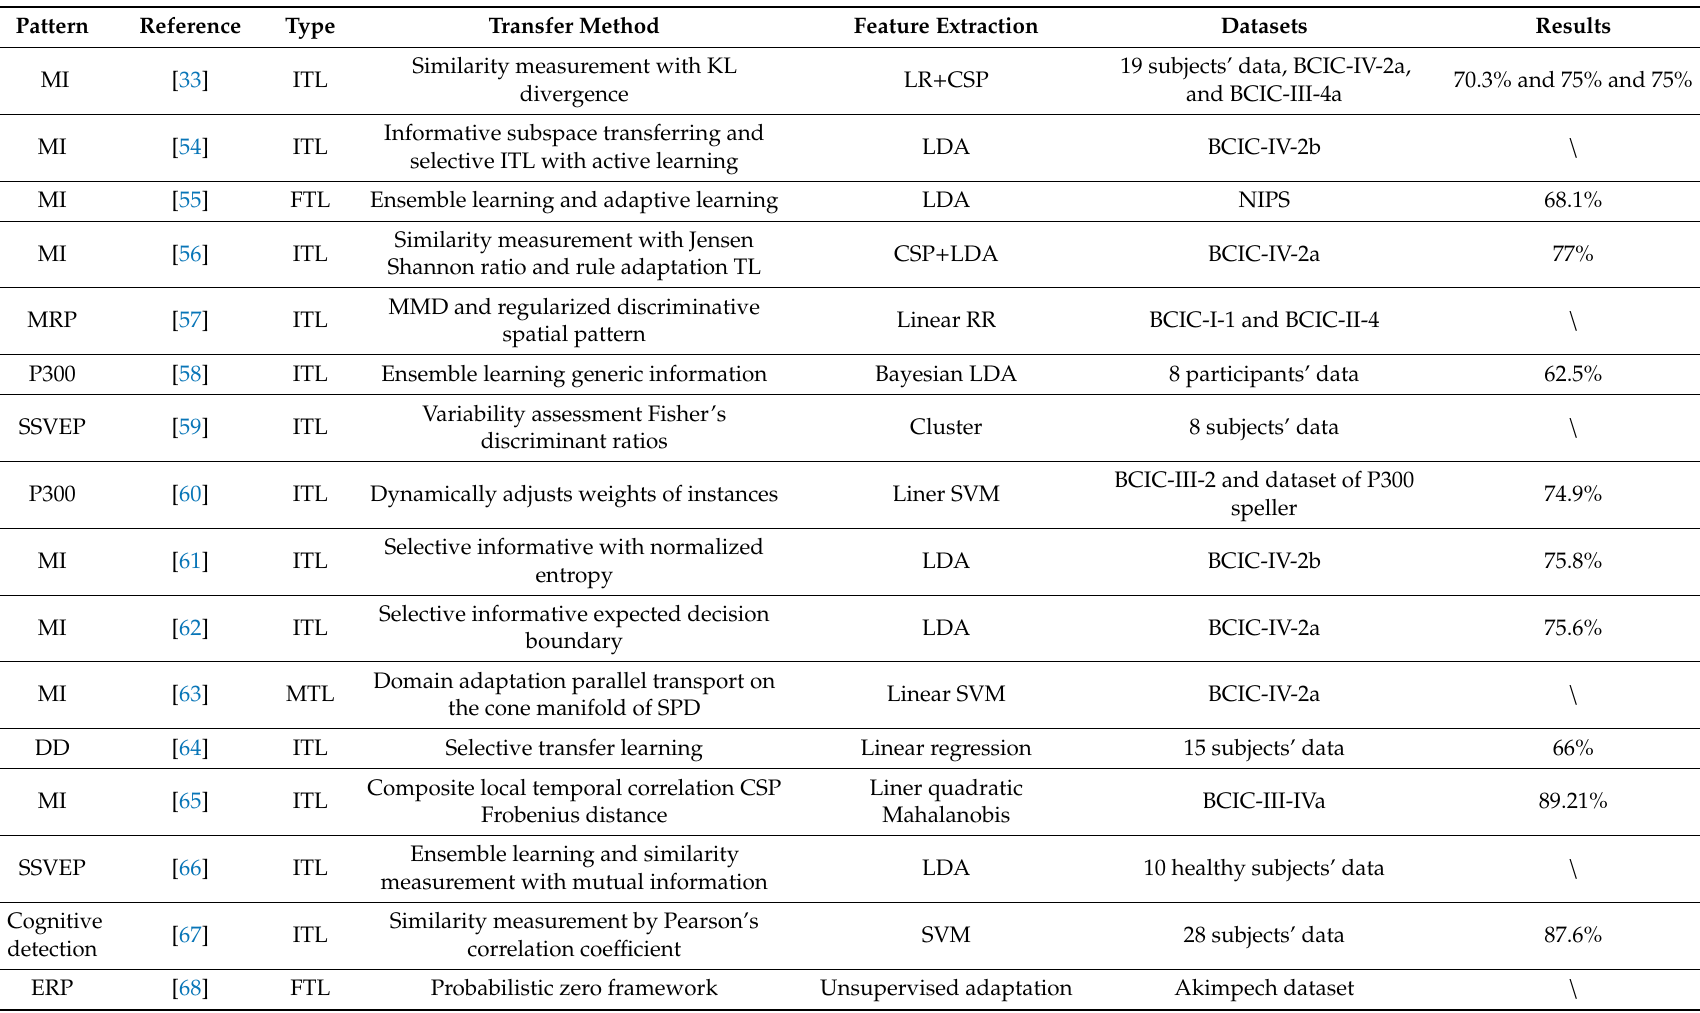
Table 3. Summary of transfer learning for EEG